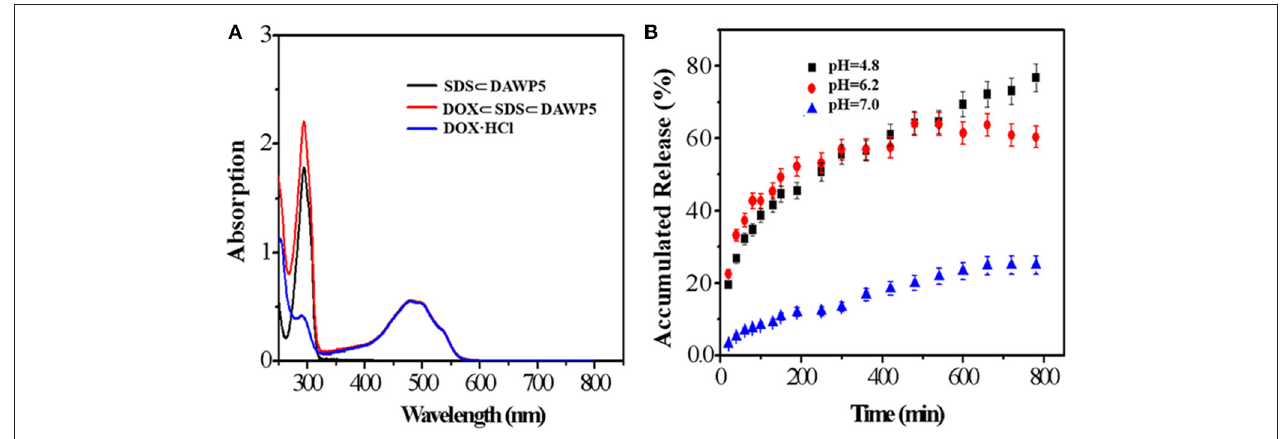
FIGURE 4 | (A) UV-vis spectra of SDS ⊂ DAWP5 vesicles, DOX and DOX ⊂ SDS ⊂ DAWP5 vesicles. (B) Time-dependent drug release of DOX ⊂ SDS ⊂ DAWP5 vesicles under different pH conditions.